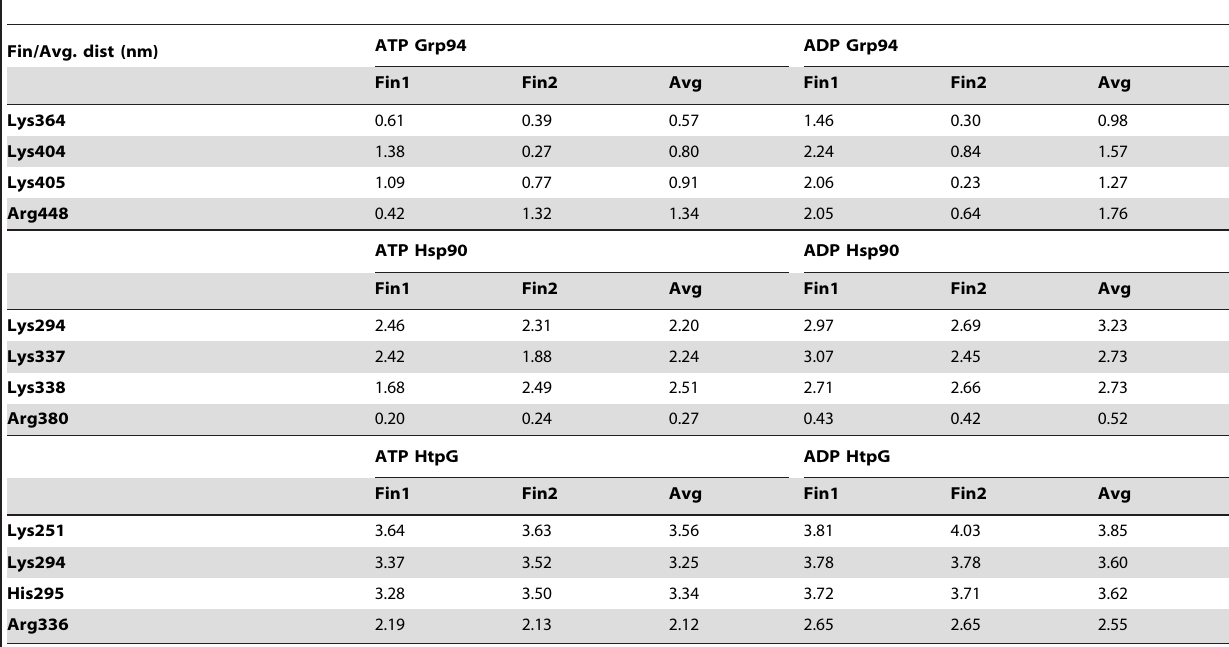
Table 1. Final and Average Distances between ATP or ADP and residues important for binding and catalysis in Grp94, Hsp90 and